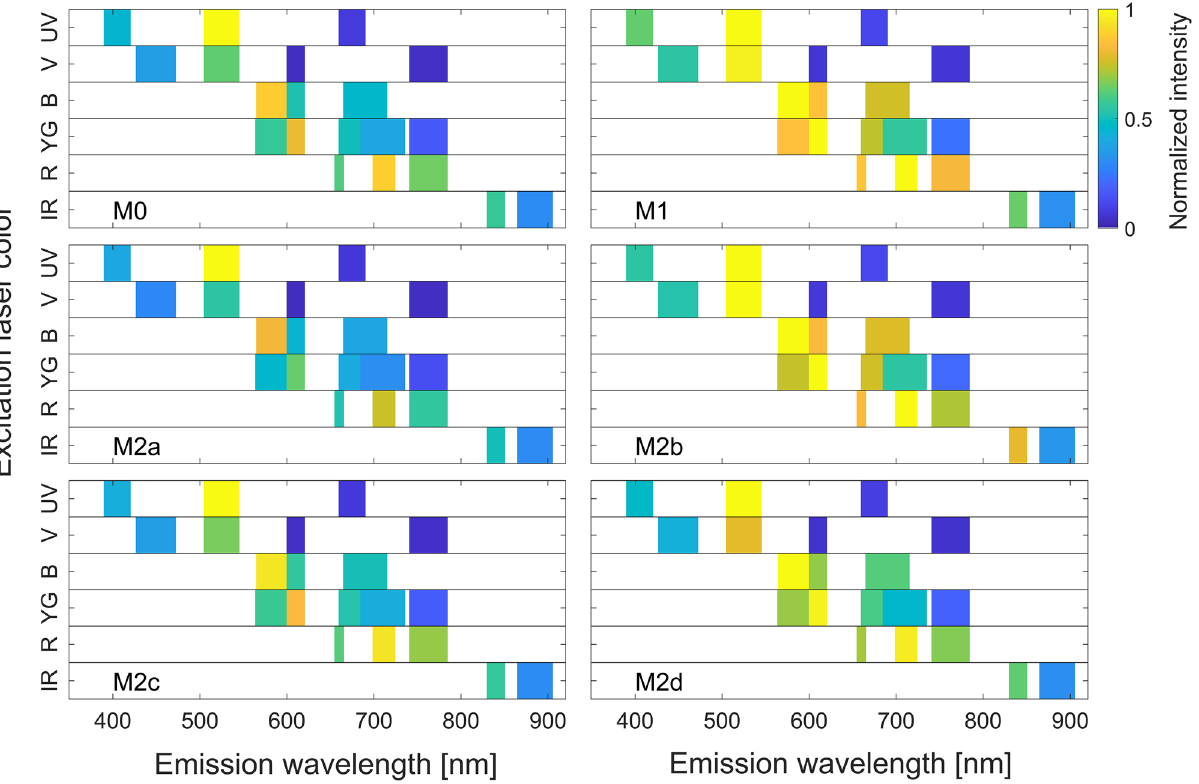
Figure 3. An intensity plot for the average height of the forward scatter signal for each macrophage phenotype. The signal is collected across all available optical detectors upon exposure to infra-red (IR), red (R), yellow/ green (YG), blue (B), violet (V), and ultraviolet (UV) lasers at emission wavelengths 808 nm, 638 nm, 561 nm, 488 nm, 405 nm, respectively. The intensity is normalized to the same scale across all phenotypes. Each colored block represents the collected signal per each detector generated after excitation with the corresponding laser.